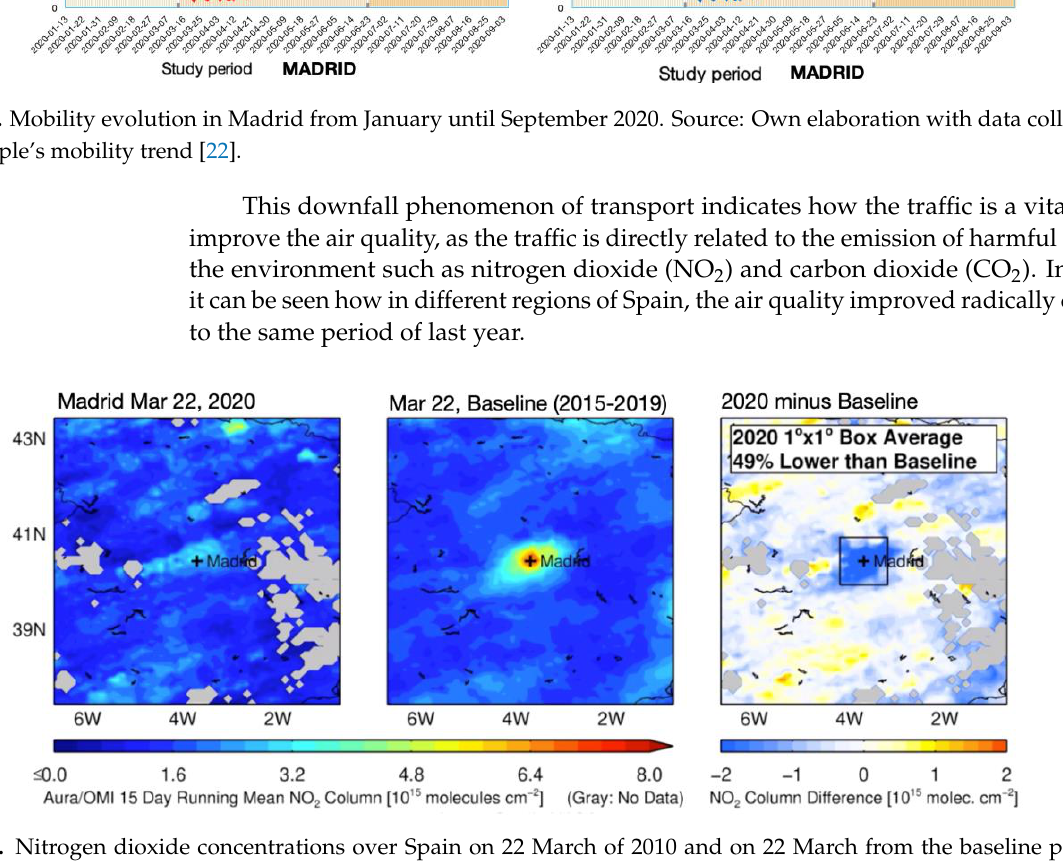
Figure 9. Nitrogen dioxide concentrations over Spain on 22 March of 2010 and on 22 March from the baseline period (2015–2019). Source: NASA AURA [23].